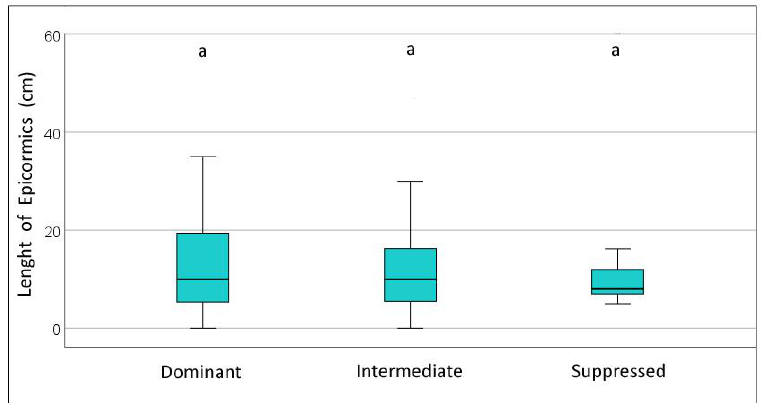
Figure 5. Number and length of epicormic branches of the trees at the end of the period for different treatments of Pyrenean oak coppice. Above: by treatment; below: by tree crown class. Box-plots with confidence intervals. Significant differences between treatments ( p < 0.05) are shown with different letters.